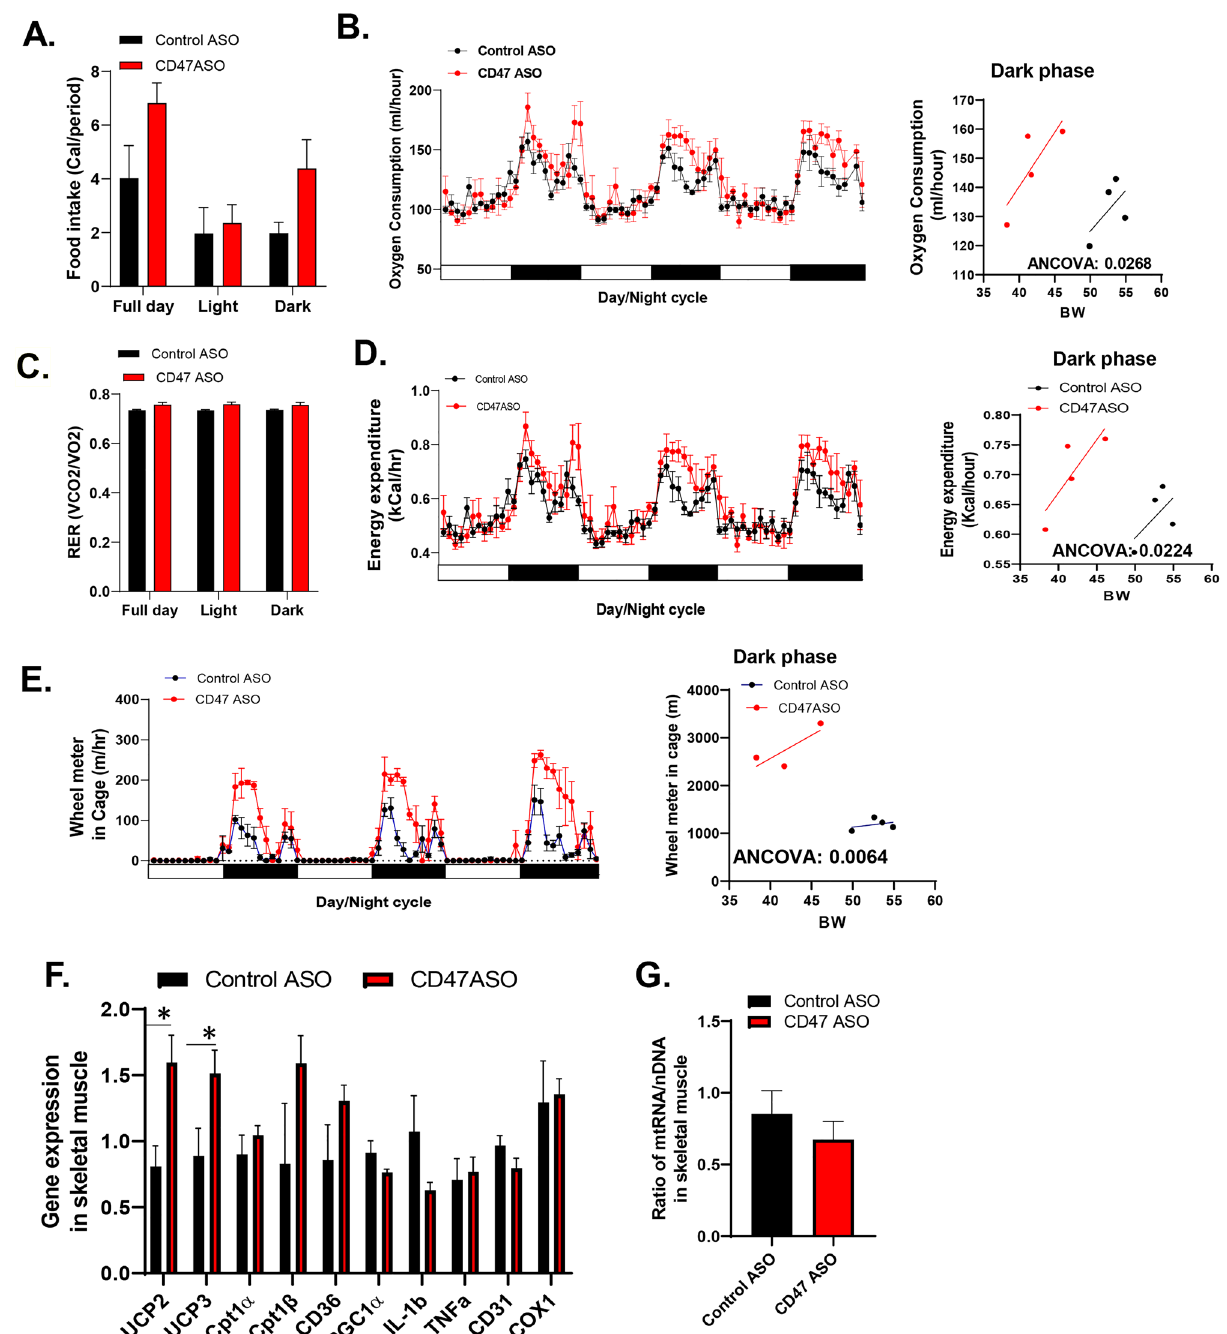
Figure 5. CD47 ASO treatment increased activity in diet-induced obese mice. Mice were housed in Sable Promethion system for indirect calorimetry analysis. ( A ) Food intake; ( B ) Oxygen consumption of three day/ night cycles and regression plot of dark period oxygen consumption versus body weight (BW); ( C ) RER (VCO2/ VO2); ( D ) Energy expenditure of three day/night cycles and regression plot of dark period energy expenditure versus BW; ( E ) Voluntary wheel running distance of three day/night cycles and regression plot of dark period wheel running distance versus BW; ( F ) Skeletal muscle gene expression by qPCR; ( G ) Skeletal muscle DNA copy number by qPCR. Data are presented as mean ± SE (n = 4 mice /group). * P <